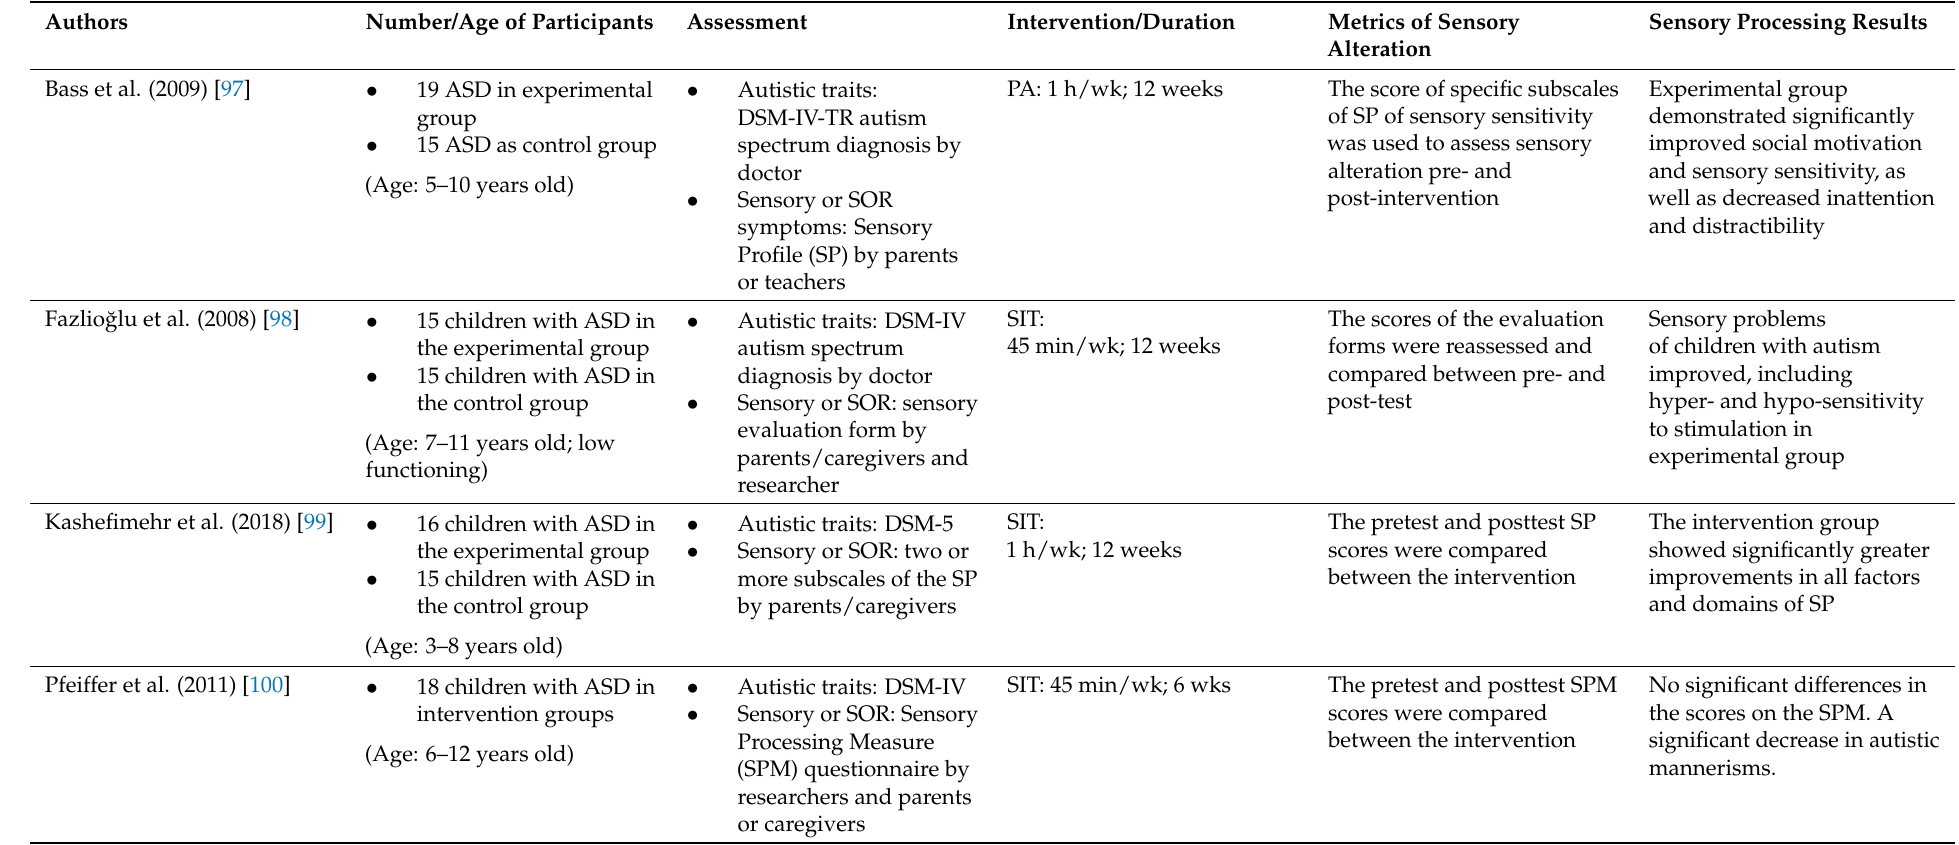
Table 2. Six sensory studies related to proposed effective intervention for SOR in this